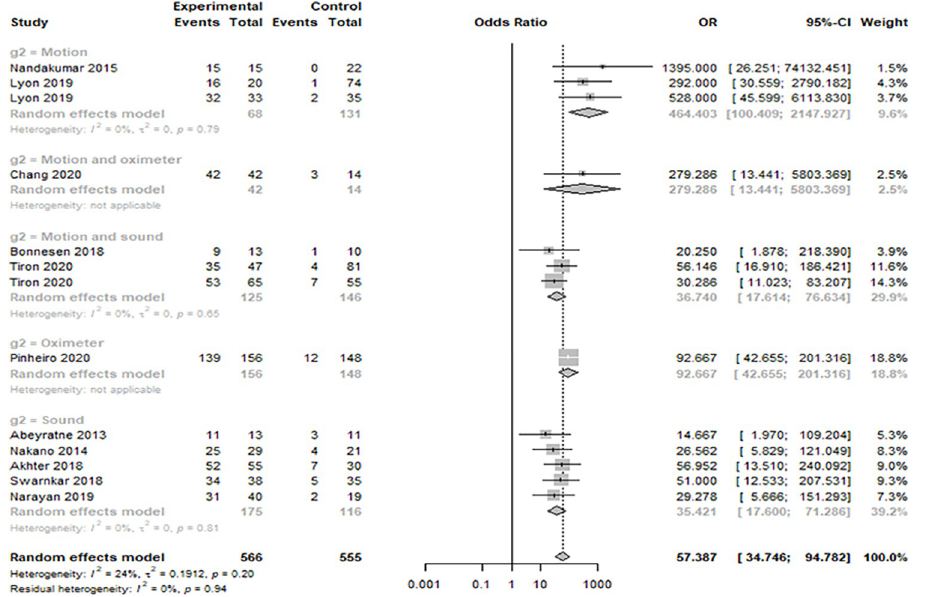
Fig 2. Forest plot of the diagnostic odds ratios of the included